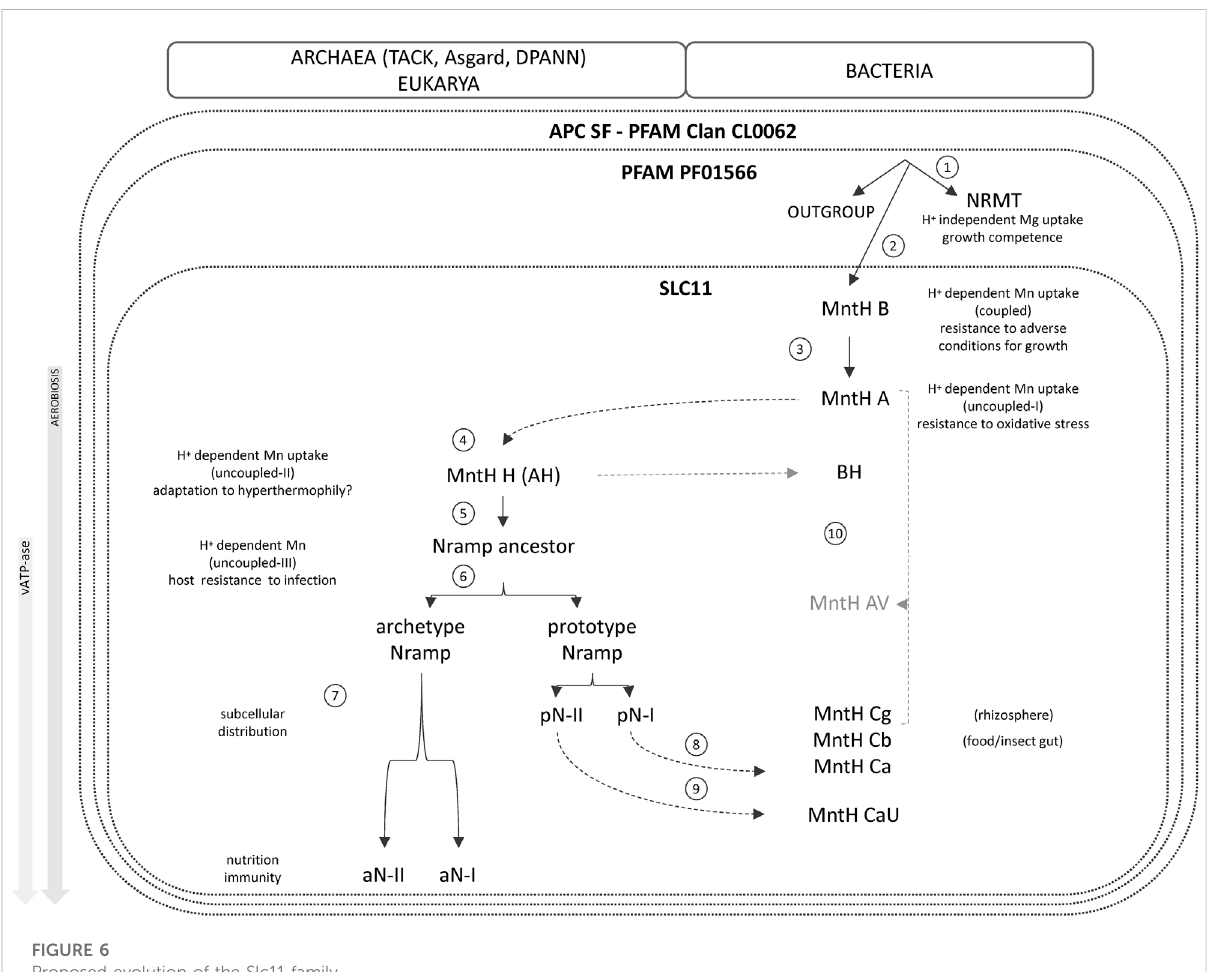
FIGURE 6 Proposed evolution of the Slc11